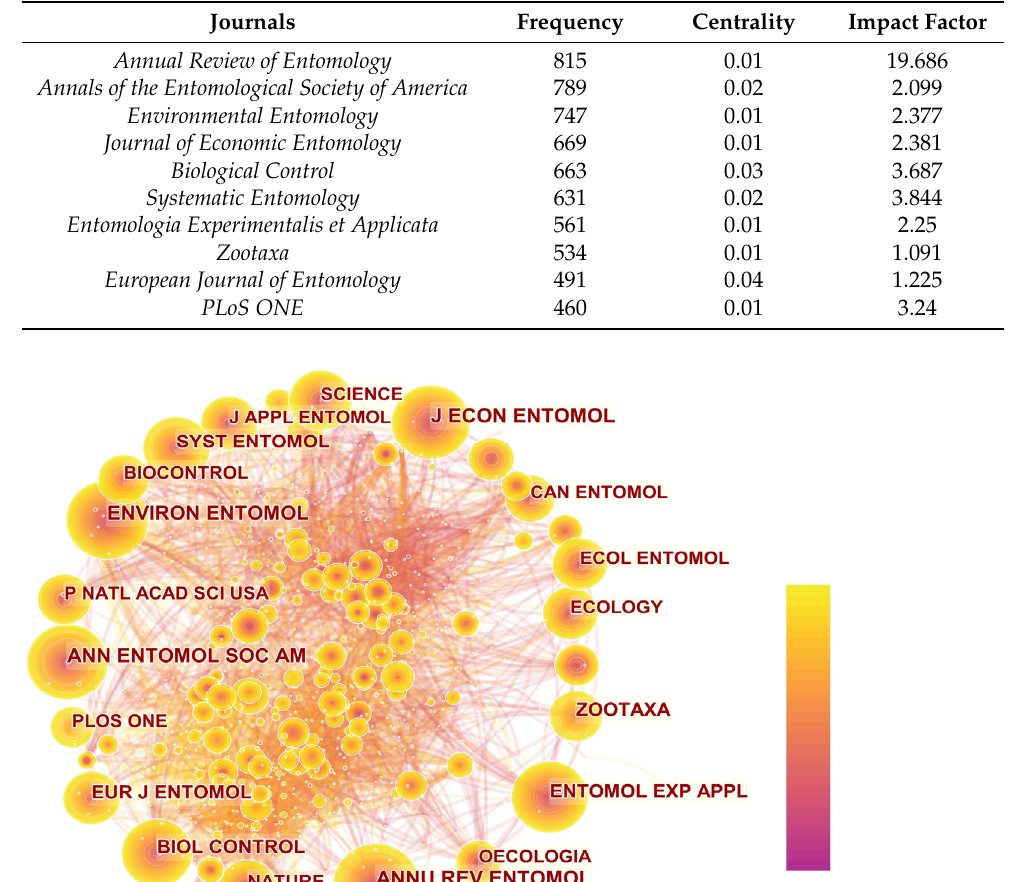
Table 4. Top 10 journals based on cited frequency.